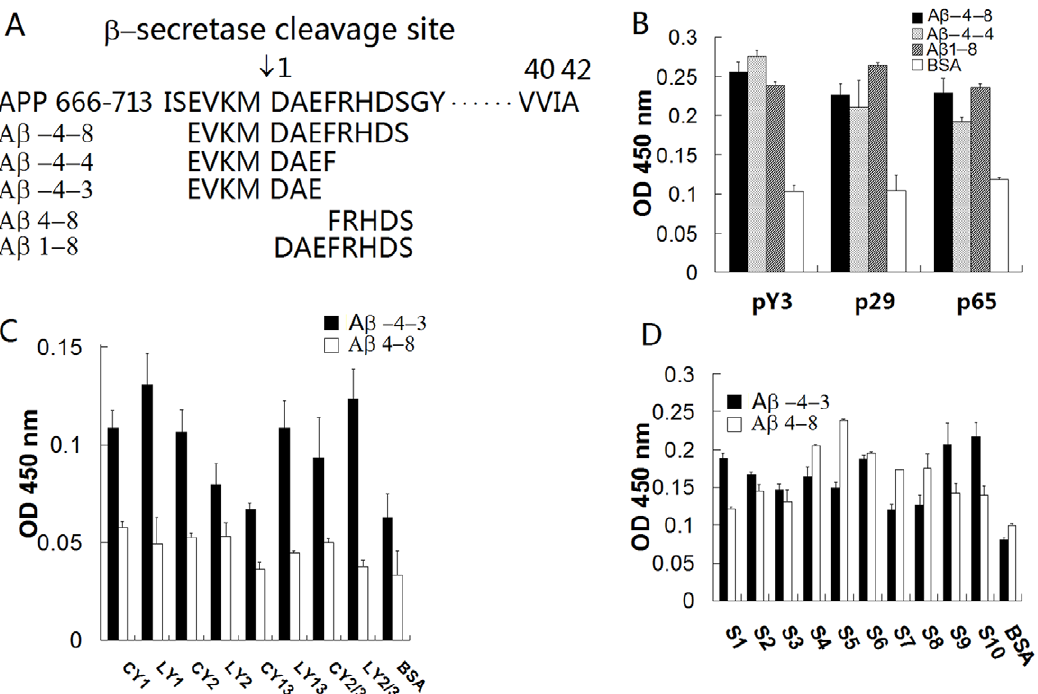
Figure 1. Binding of isolated peptides to the b -secretase cleavage sites of APP and the N-terminal of A b . (A) The peptides of the b - secretase cleavage sites of APP and the N-terminal of A b used in this study. (B) A b -4-8, A b -4-4 and A b 1-8 were coated on an amine-binding 96-well ELISA plate. Three of the selected phage clones were added to the wells. The HRP-9E10 antibody was added to the wells, followed by TMB substrate. Absorbance was read at 450 nm. (C) The peptides displaying positive phage clones were synthesized and coated on an amine-binding 96-well ELISA plate. A b -4-3 and A b 4-8 with His-tags were added to the wells. Mouse anti-His tag antibodies and HRP-conjugated anti-mouse antibodies were sequentially added to the wells and the absorbance was measured as in (B). (D) The chimeric peptides were coated to an amine-binding ELISA plate. A b -4-3 and A b 4-8 with His-tags were added to the wells. Mouse anti-His tag antibodies and HRP-conjugated anti-mouse antibodies were sequentially added to the wells and the absorbance was measured as in